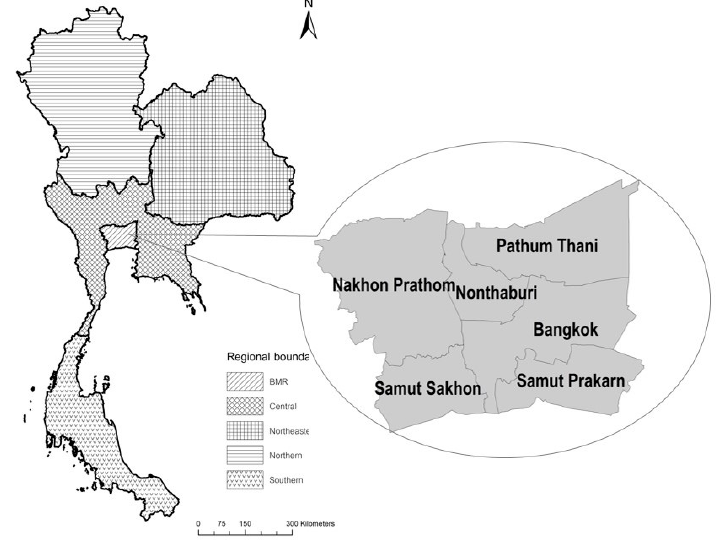
Figure 1. Map of Thailand and boundary of BMR-site study.